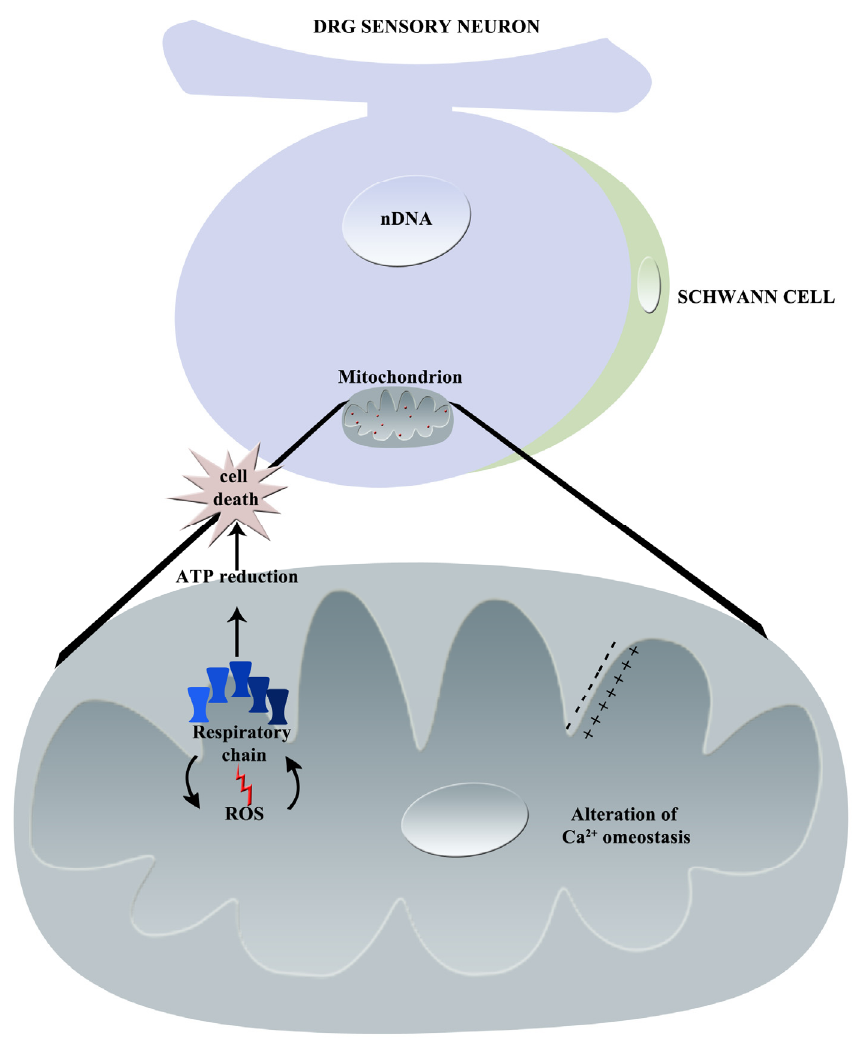
Figure 4. Graphical summary of vincristine-induced mechanisms of neurotoxicity: principal effects on mitochondrion (nDNA = nuclear DNA, ROS = Reactive Oxygen Species, Ca 2+ =